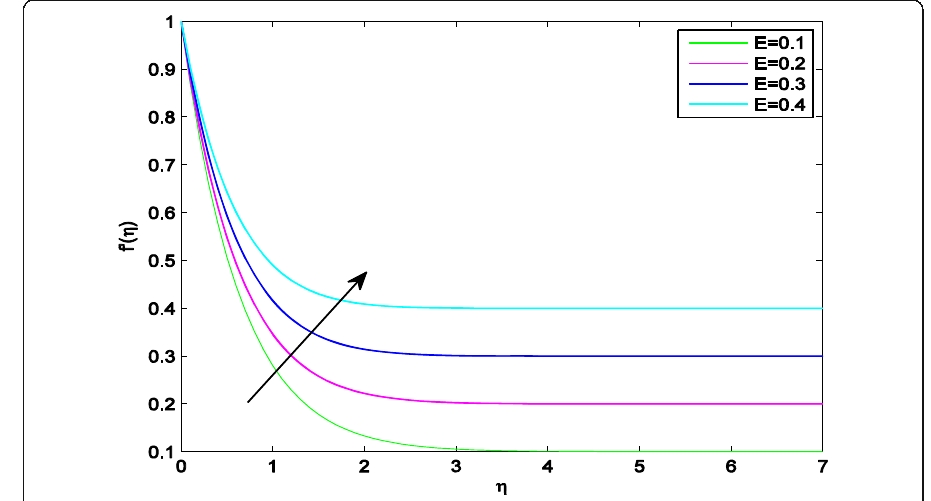
Fig. 10 Velocity graph for various values of